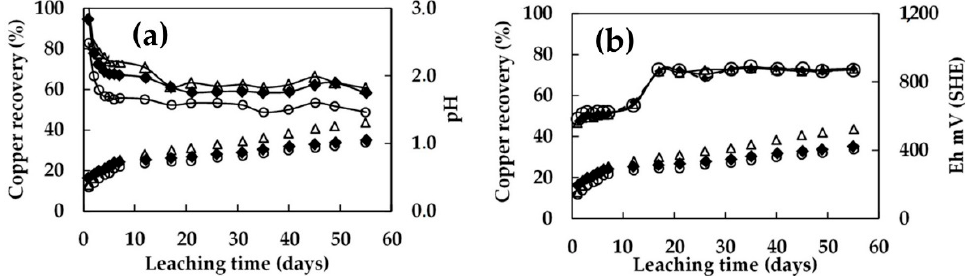
Figure 6. Effects of adding 1.5 × 10 8 cells/mL of microorganism on the rate of column leaching of chalcopyrite ore at different pH levels with continuous irrigation. pH 2.0; ♦ pH 1.8; pH 1.5. ( a ) Variation in pH (dashed line); ( b ) variation in Eh (dashed line).